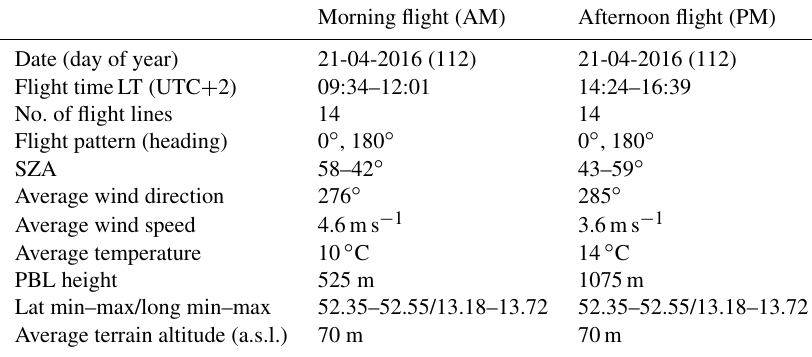
Table 1. Flight characteristics of the AROMAPEX data sets, acquired over the city of Berlin.